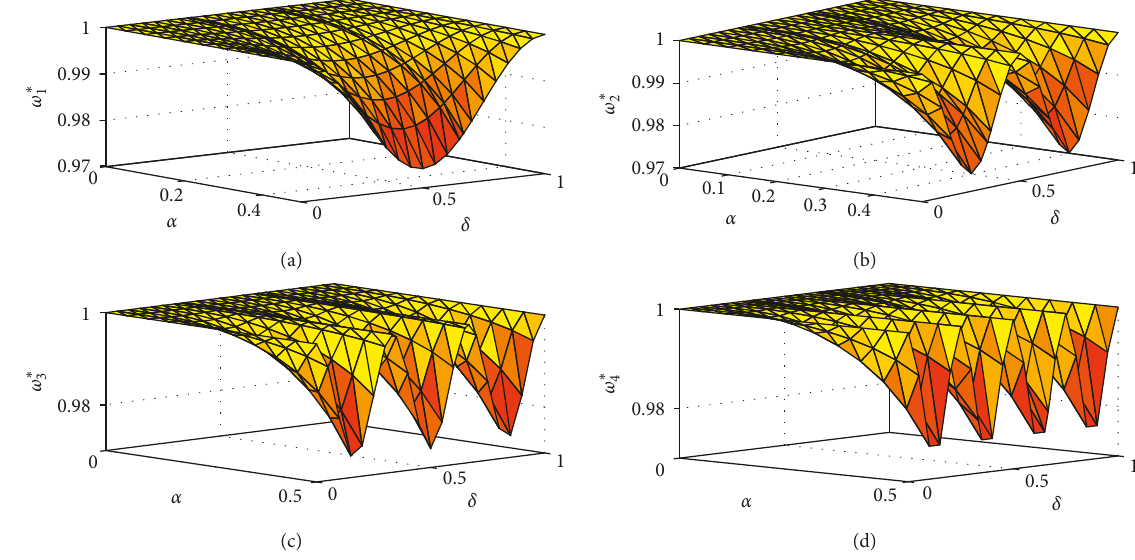
Figure 3: Variations of the first four normalized frequencies in terms of crack depth ( α ) and position ( δ ) for c